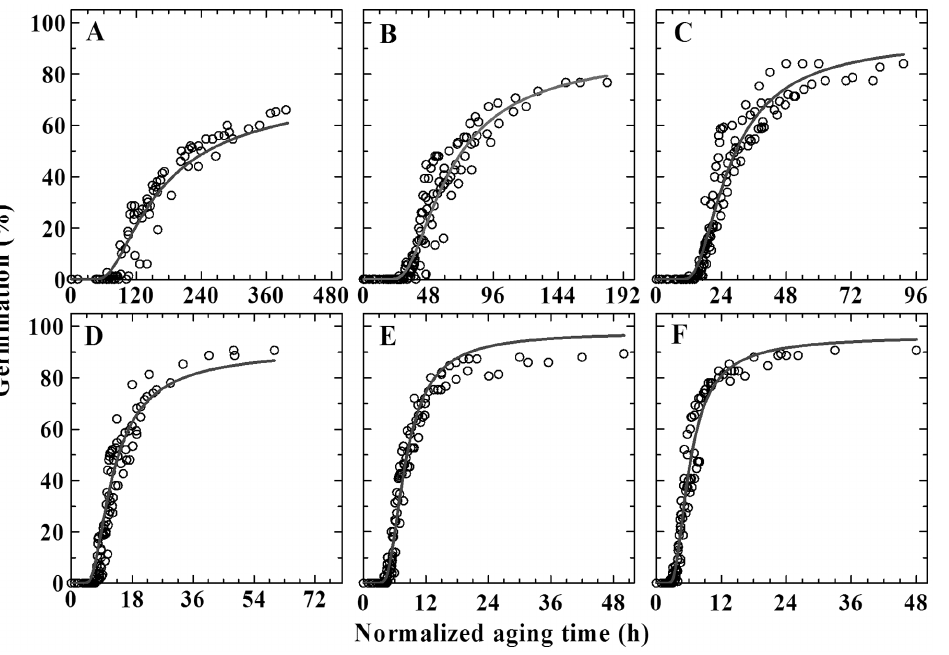
Figure 2. Normalized time course of germination for seeds at various temperatures. The actual times of germination for seeds stored for 5, 10, 15, 20, 25, 45, and 65 days at a given temperature of 5 (A), 10 (B), 15 (C), 20 (D), 25 (E) or 30 u C (F) were normalized to the time course for control seeds at that temperature according to equation (5) and then plotted against germination percentage of seeds. The empty circles are the actual data and the gray curves are predicted from equation (4) with parameters in Table 2. doi:10.1371/journal.pone.0062868.g002 normalized thermal time scale and all fit a common predicted curve (Figures 4B and D).